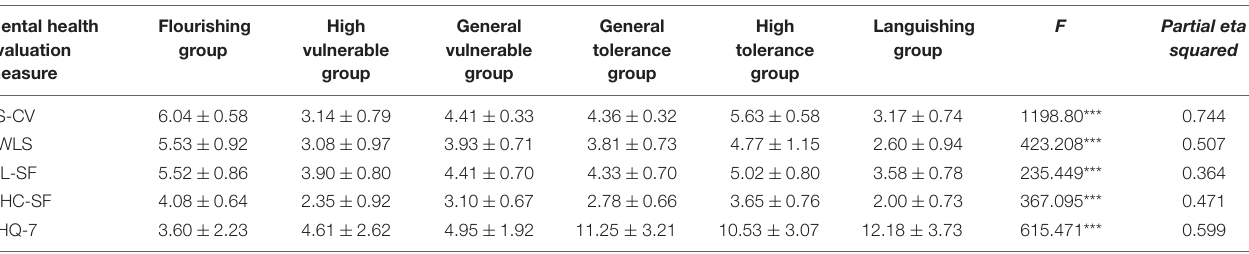
TABLE 4 | Comparison of the college students’ positive and negative mental states between the six categories. Mental health